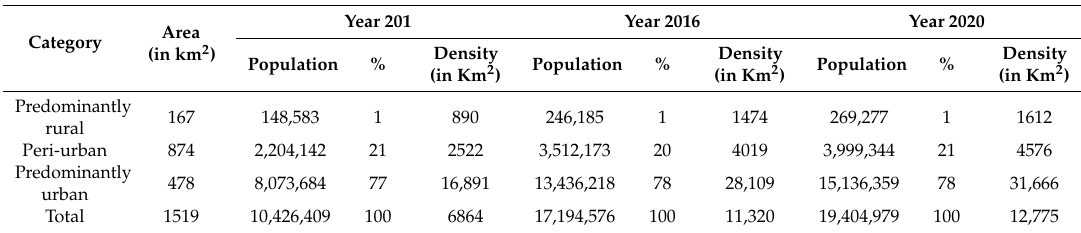
Table 8. Distribution of population between predominantly rural areas, peri-urban areas, and predominantly urban areas based on NTL VIIRS 2016 data